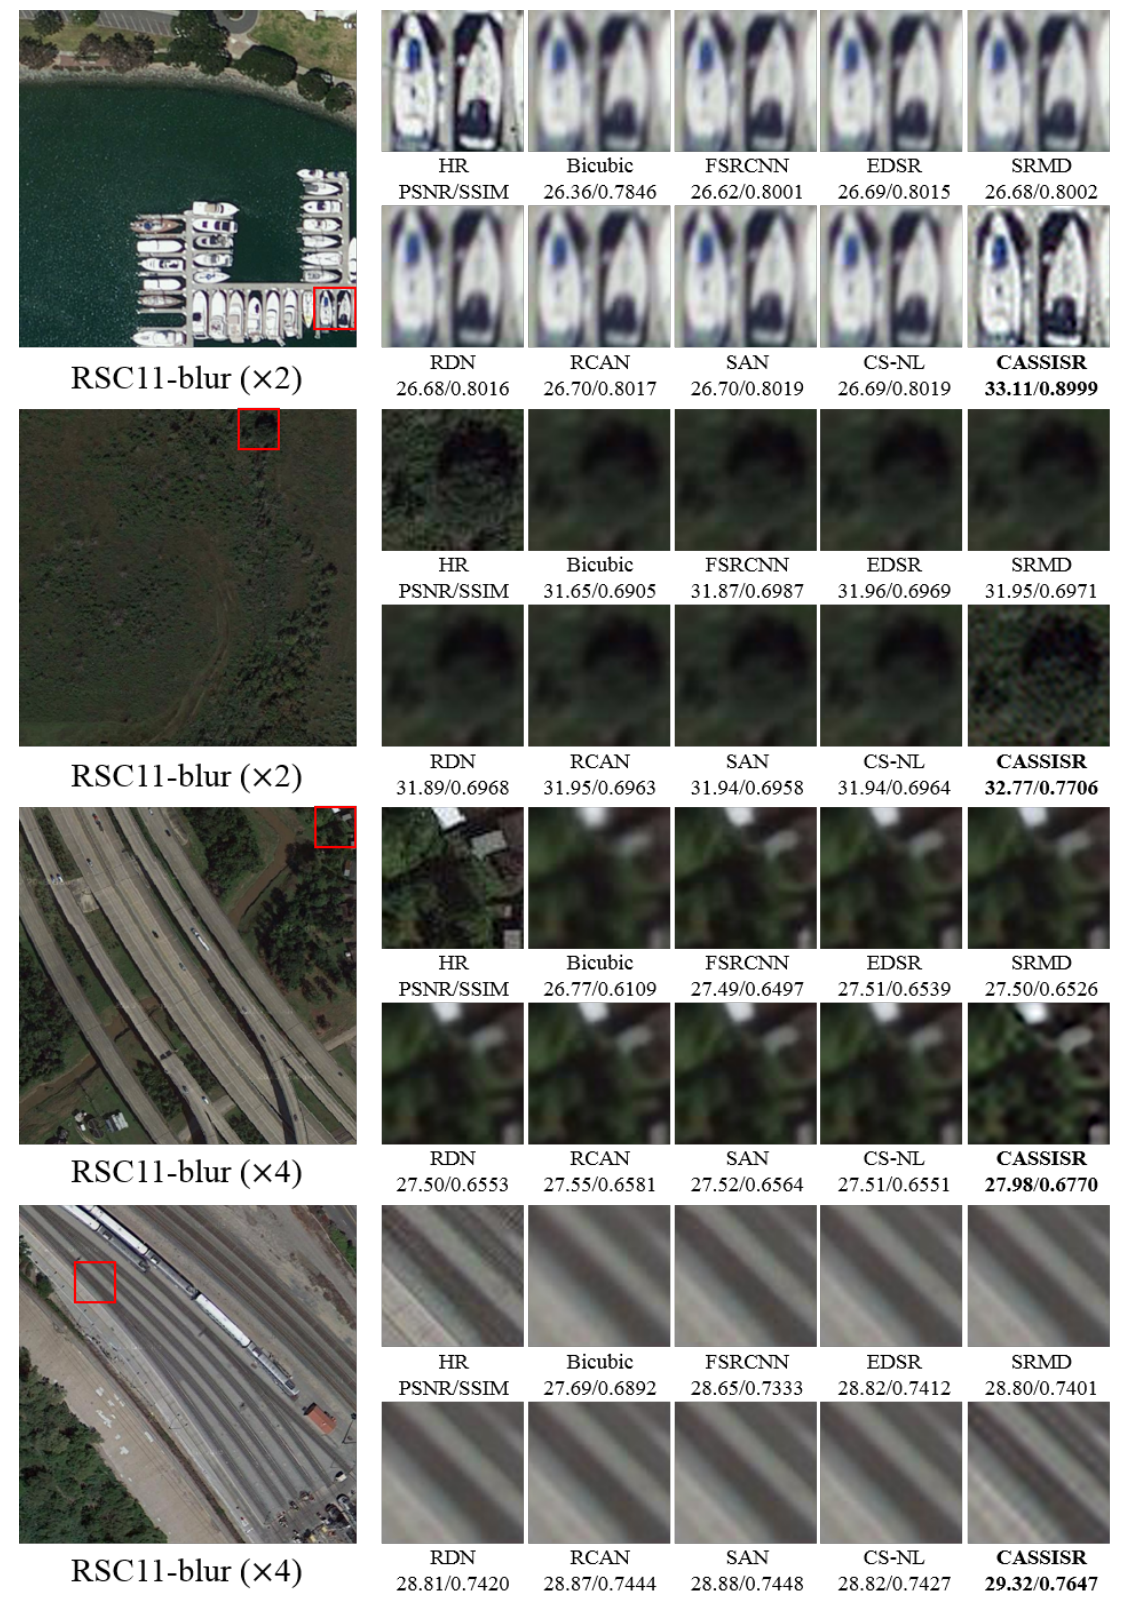
Figure 5. Qualitative comparison of scaling factors × 2 and × 4 between CASSISR and CNN-based SR methods on RSC11- blur dataset. Our CASSISR results are highlighted